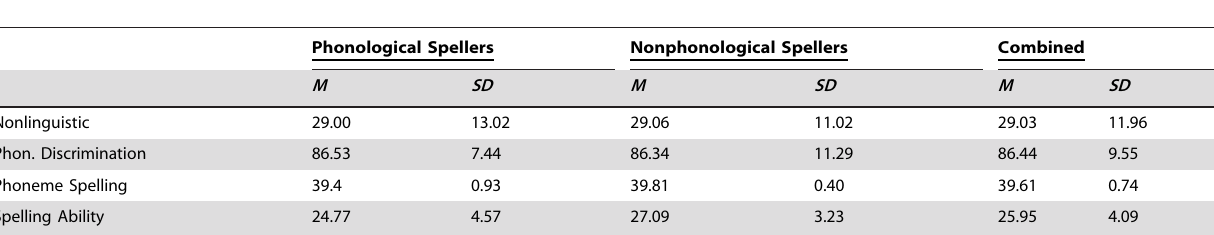
Table 1. Means and Standard Deviations for Accuracy in Auditory Processing and Spelling Tasks.